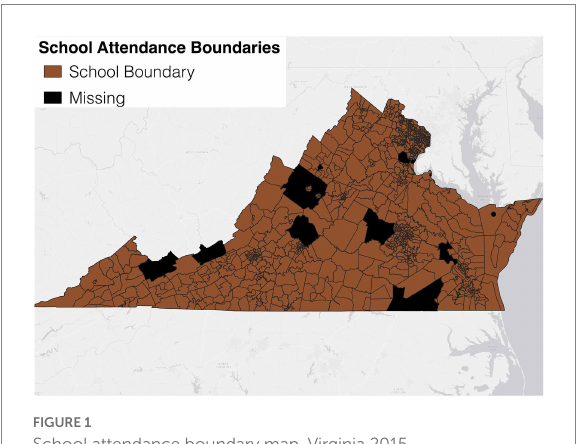
FIGURE 1 School attendance boundary map, Virginia